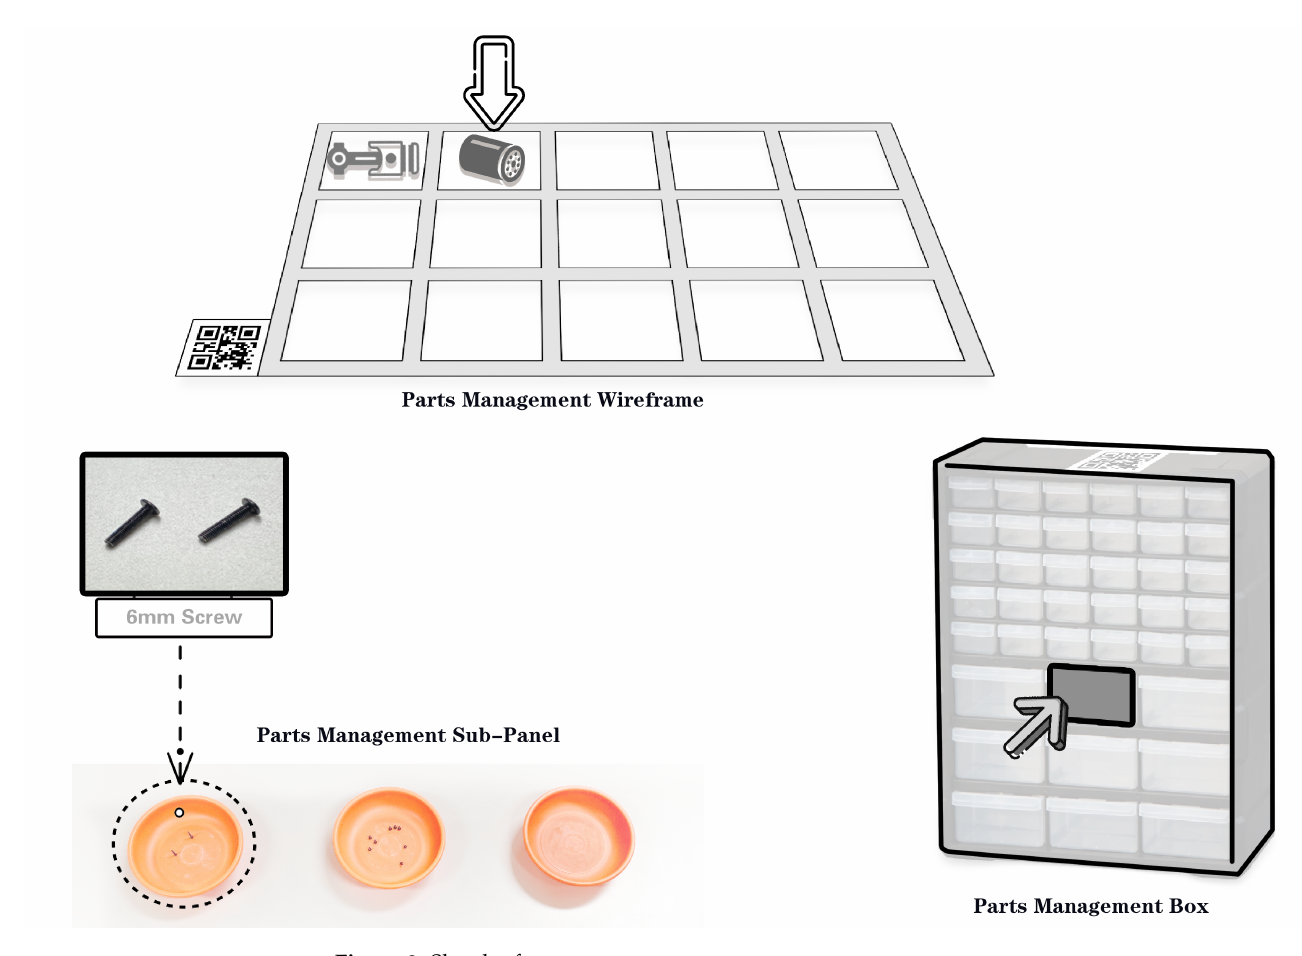
Figure 9. Sketch of parts management